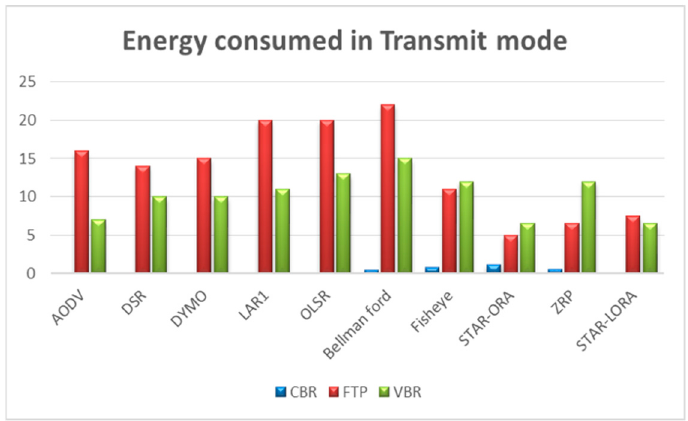
Figure 12. Transmit mode energy consumption of all routing protocols for 60 nodes.